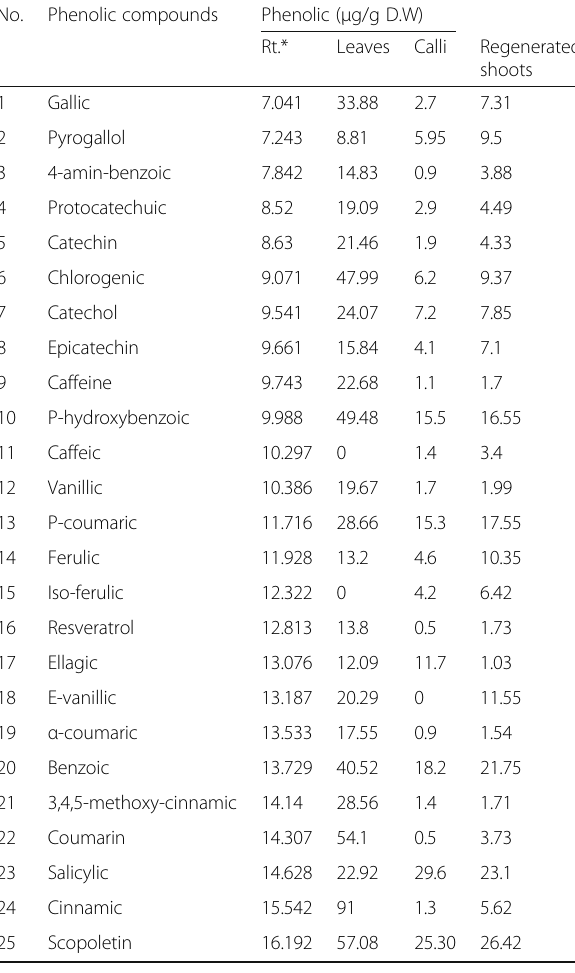
Table 4 Results of phenolic compounds identified by RP-HPLC in different extracts (80% MeOH) of leaves, calli, and regenerated shoots of Diospyros kaki L. cv. Costata that appear at λ max 280